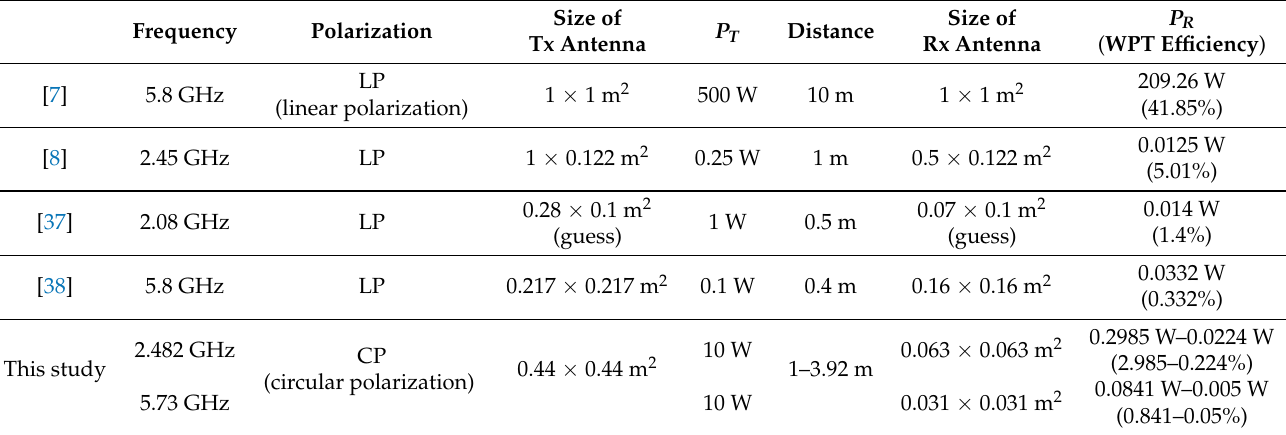
Table 6. Comparisons of previous studies of RF